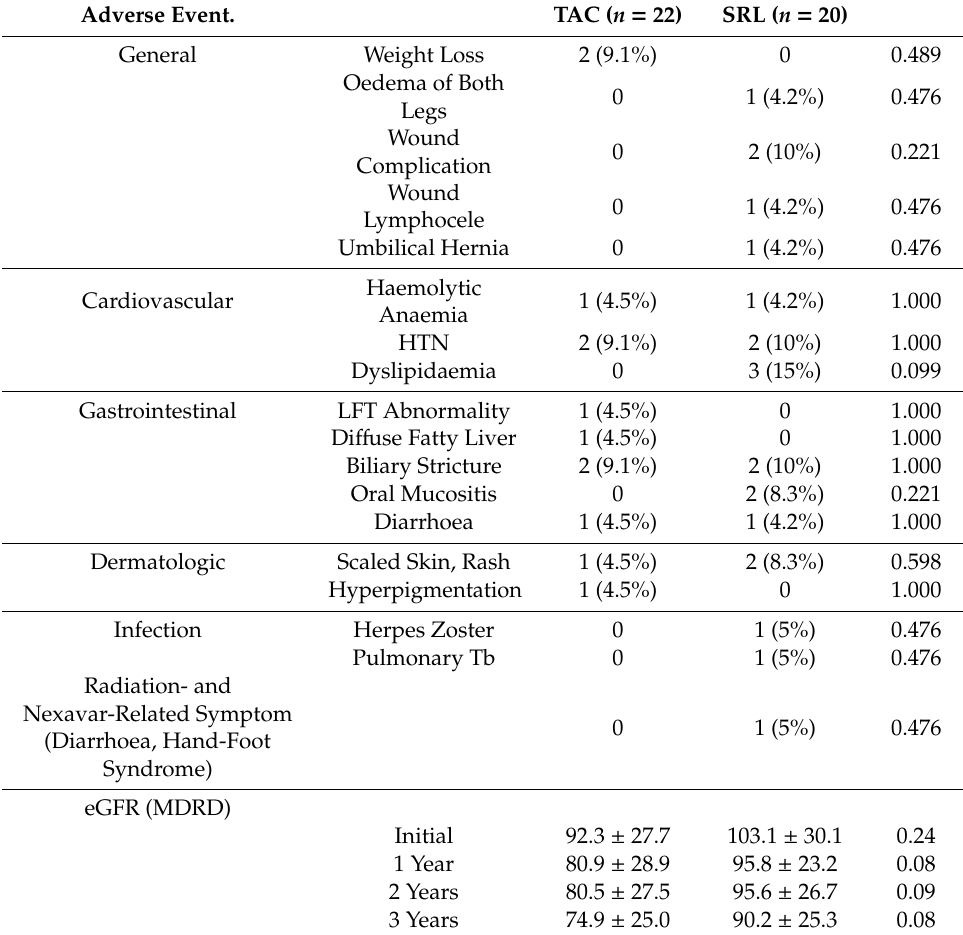
Table 4. Number and distribution of relevant adverse events and eGFR. Adverse